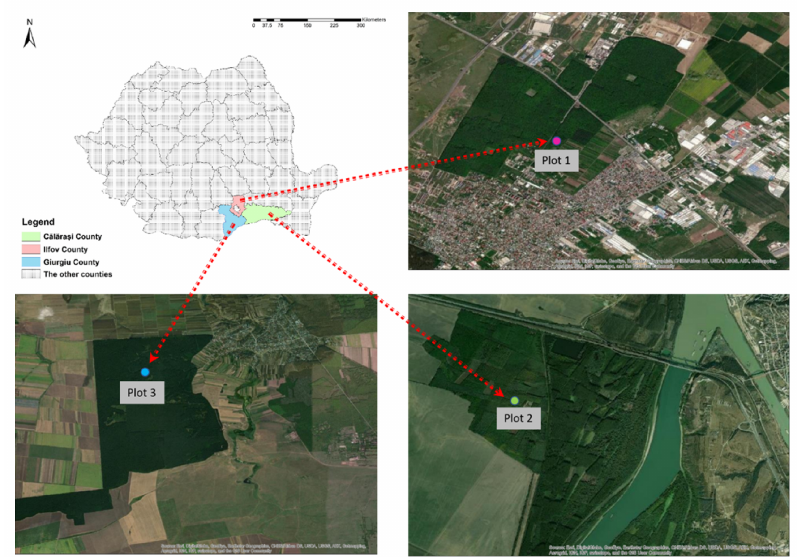
Figure 1. Location of the study area (Esri, Maxar, GeoEye, Earthstar Geographics, CNES/Airbus DS, USDA, USGS, Aero Grid, IGN, and the GIS User